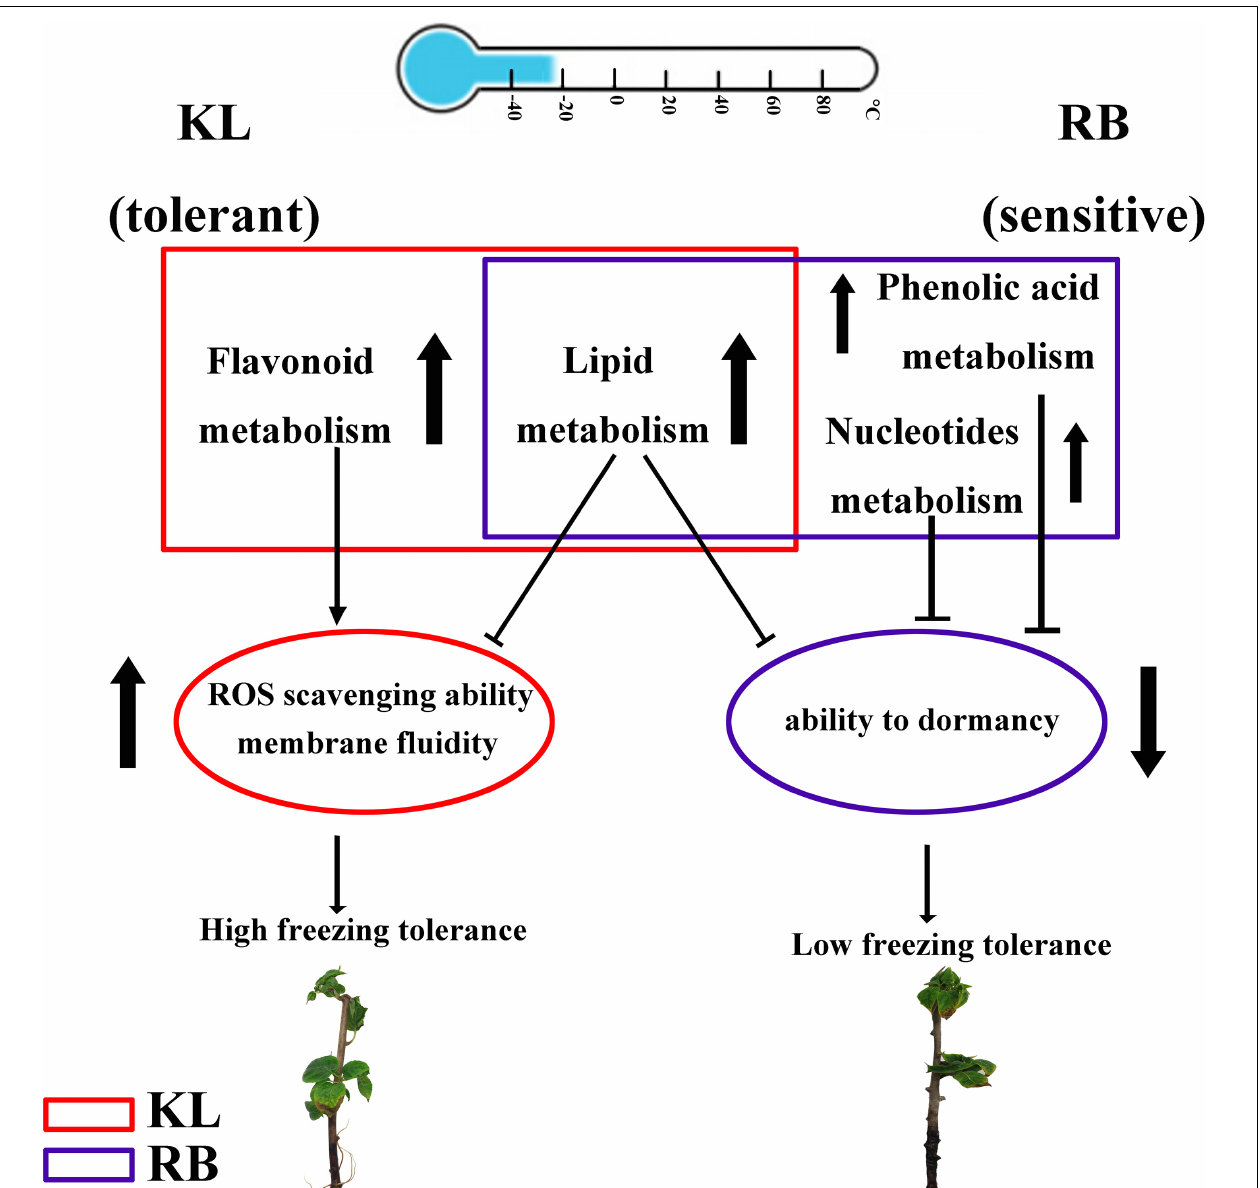
FIGURE 10 | Proposed freezing tolerance models for A. arguta . In KL, flavonoid metabolism was specifically upregulated in KL under the cold treatment, which increased its ability to scavenge ROS. In RB, both phenolic acid metabolism and nucleotide metabolism were specifically upregulated in RB under the cold treatment, which decreased its ability to tolerate freezing by weakening its dormancy ability. For lipid metabolism, metabolites were accumulated in both genotypes, which impaired membrane integrity and could serve as biomarkers of cold damage to